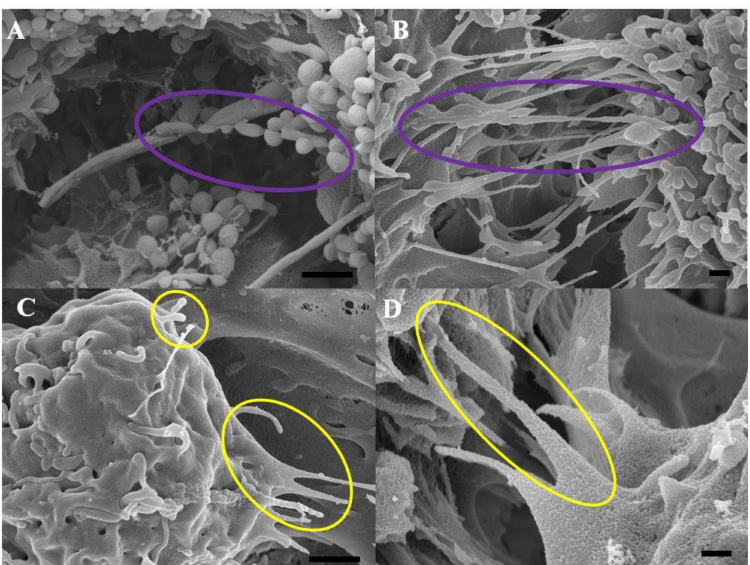
Figure 1. HR-SEM micrographs representing BEC bEnd5 NTs that are subdivided into two types: ( A ) NV-induced TUNTs indicated by the purple circles, scale bar 1000 nm; ( B ) TUNT formation and extension across the PC space between adjacent BECs, upon the fusion of multiple NVs, scale bar = 300 nm; ( C ) TENTs formed by the BEC membrane leading edges as indicated by the yellow circles, scale bar = 1000 nm; ( D ) A magnified TENT extension across the PC space between two adjacent BECs forming an occluded tent-like covering, scale bar = 300